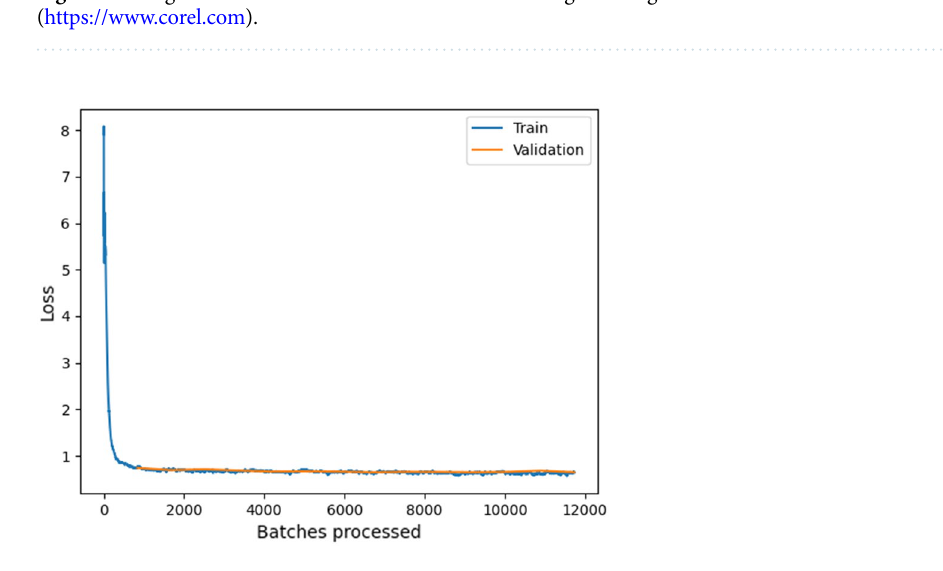
Figure 5. Training losses and validating losses over training batches. The figure was generated in ArcGIS Pro v2.8 (https:// www. esri.